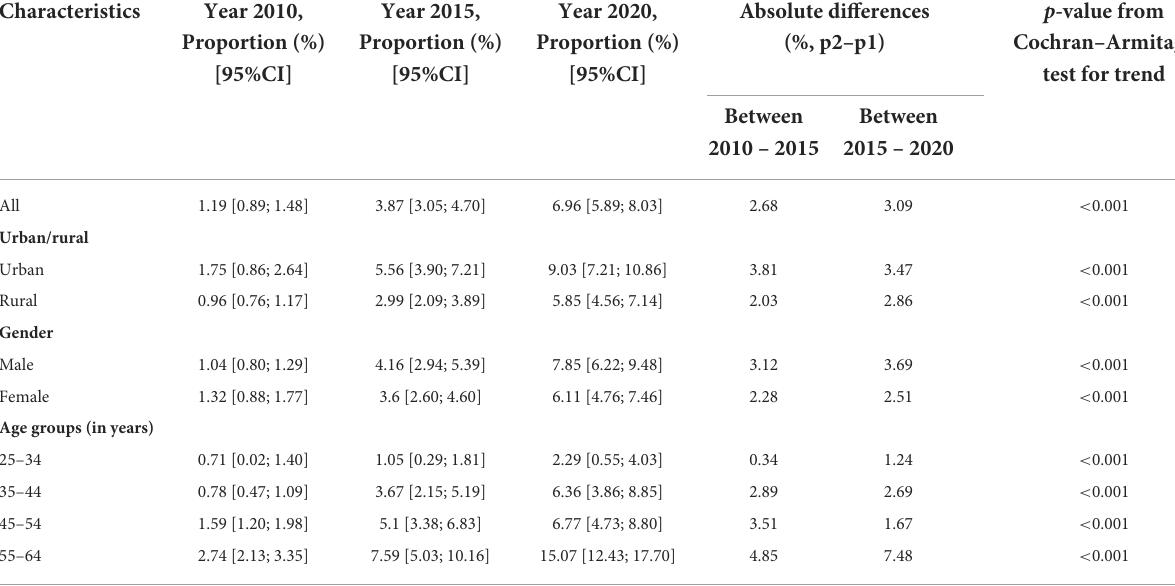
TABLE 3 Changes in the prevalence of increased blood glucose over time.